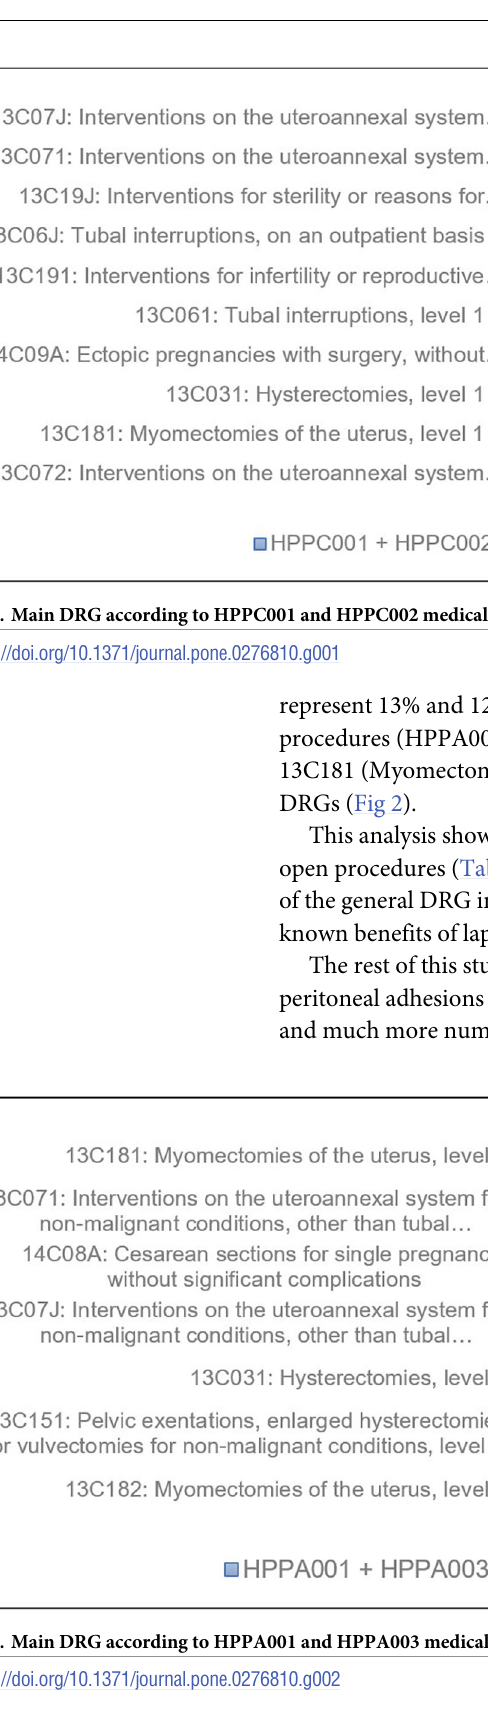
PLOS ONE | https://doi.org/10.1371/journal.pone.0276810 October 27,